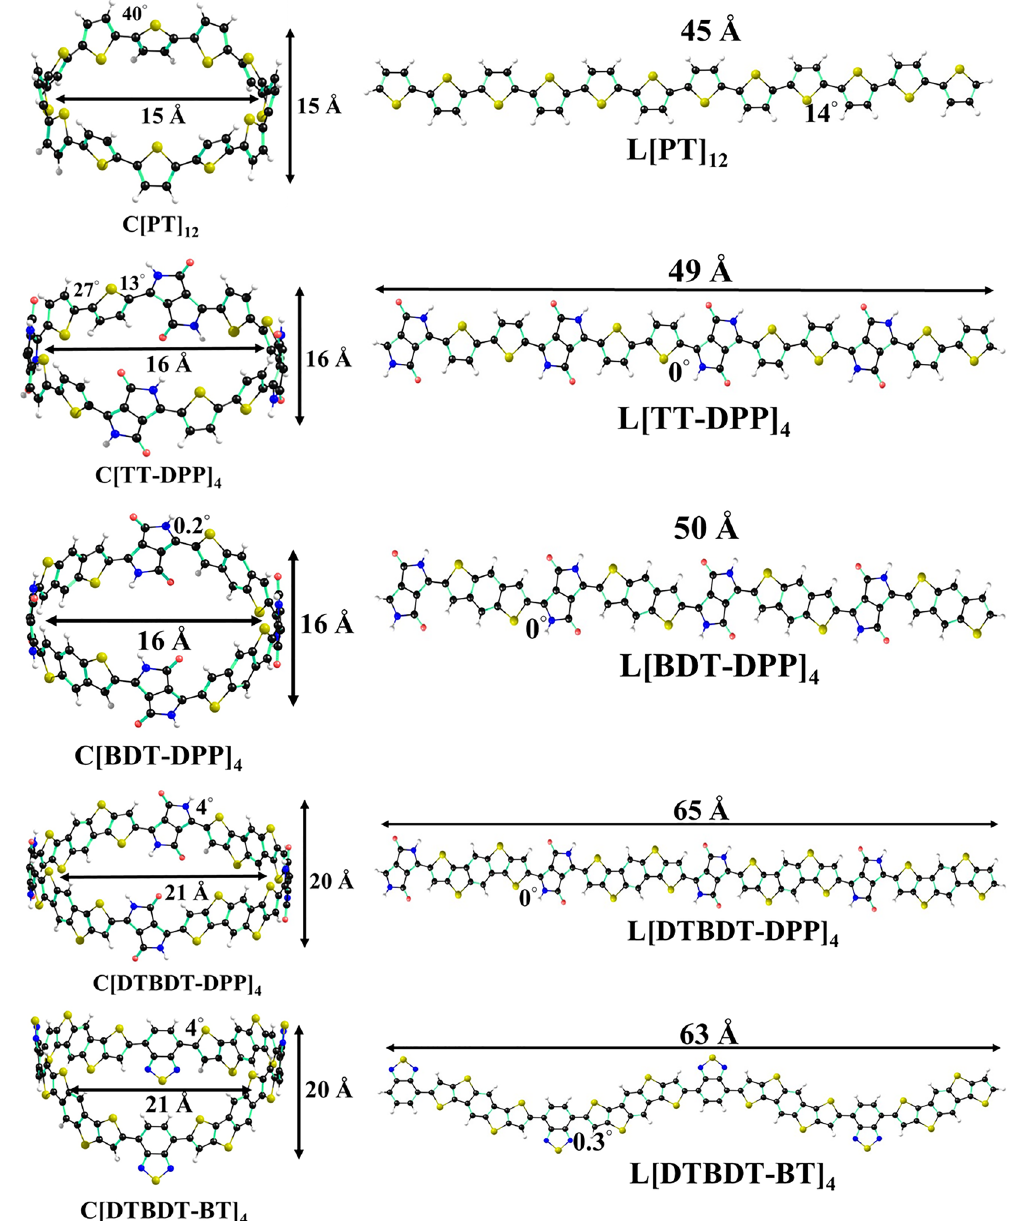
Figure 2. Optimized geometries of cyclic (C[PT] 12 , C[TT-DPP] 4 , C[BDT-DPP] 4 , C[DTBDT-DPP] 4 , and